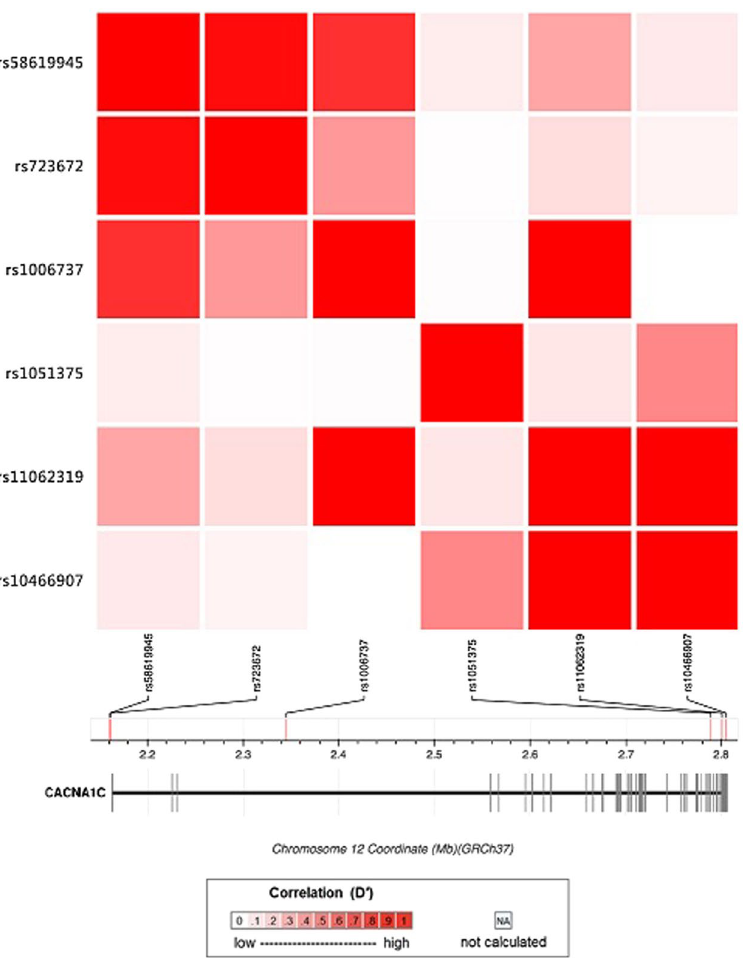
Figure 2. Linkage disequilibrium matrix of the studied CACNA1C SNPs rs1006737, rs1051375, rs723672, rs10466907, rs11062319, and rs58619945 in Han Chinese in Beijing, China. Note: CACNA1C: calcium voltage- gated channel subunit alpha1 C; SNPs: single nucleotide